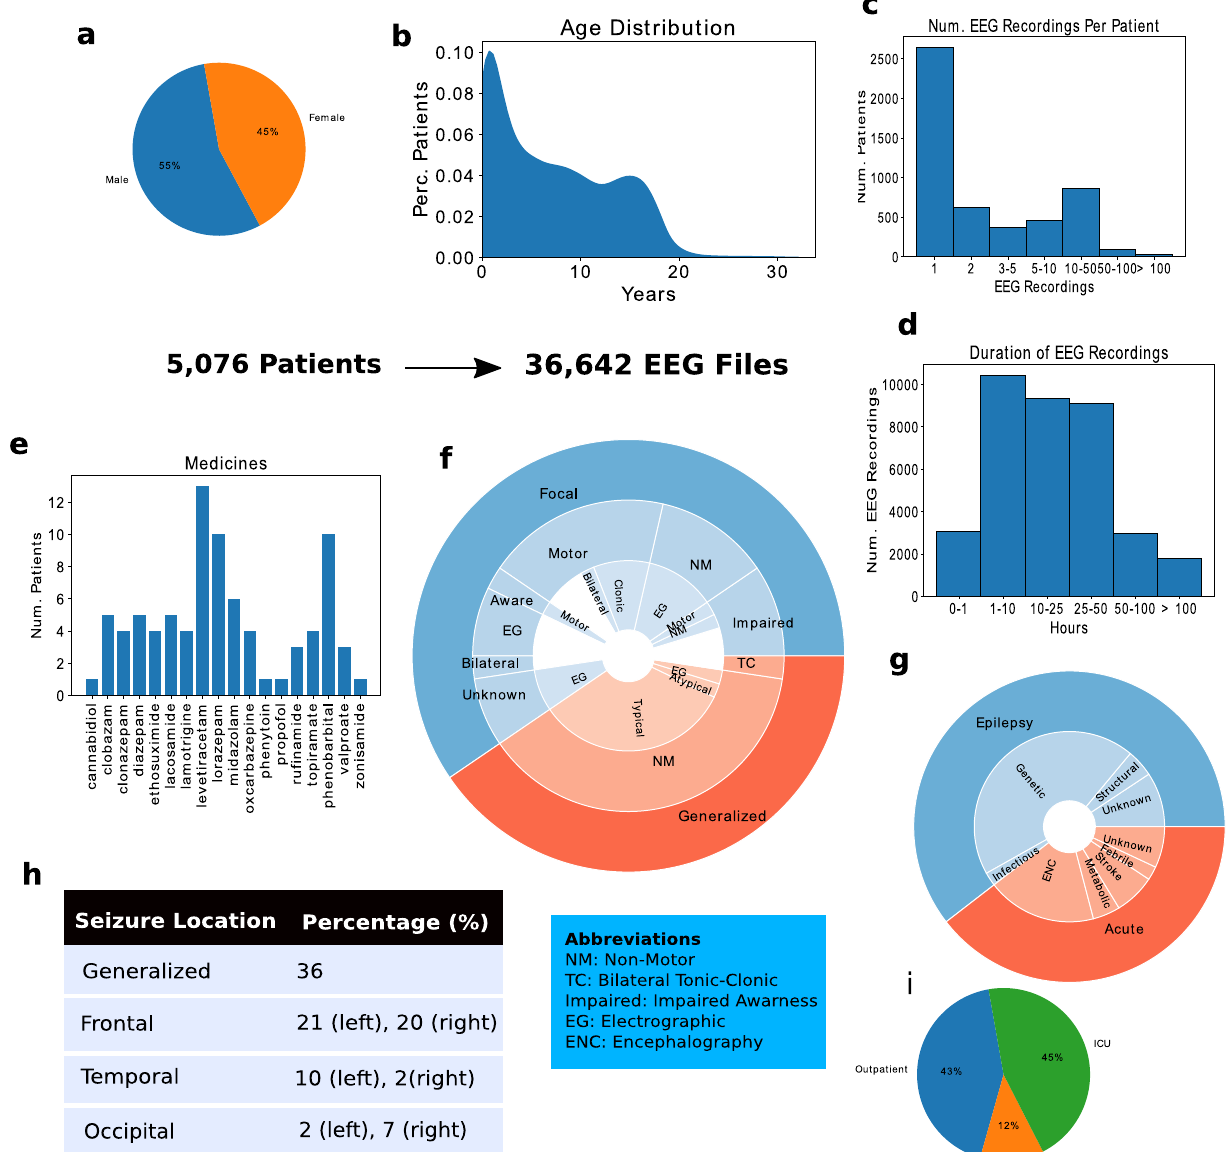
Fig. 2 Data description for Lucile Packard Children ’ s Hospital (LPCH). a the gender distribution, b the age distribution, c the number of EEG recordings per patient, d the durations of EEG recordings in hours, e a histogram of the medicine types, f a hierarchical pie graph describing the different seizure types, g a hierarchical pie graph describing etiology types, h the percentages of EEG signals collected in different locations, and i the distribution of seizure locations. Sub fi gures a – d are statistics on the entire dataset, while e – i are on the held-out test set that included 52